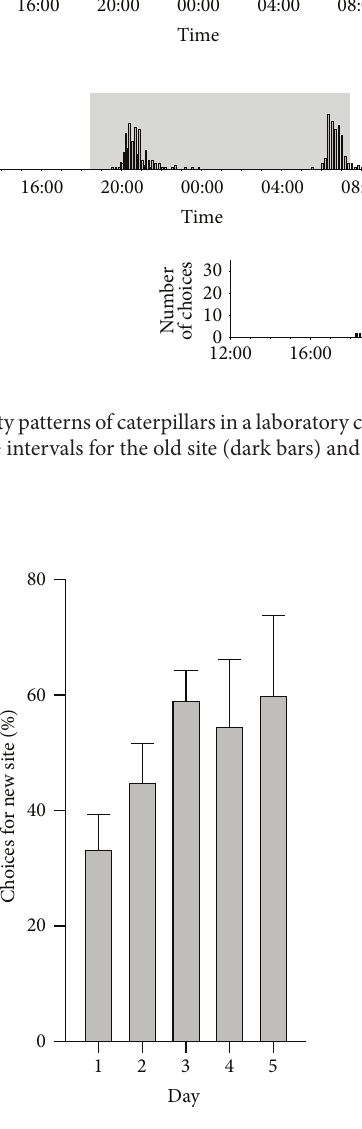
Figure 4: Mean percent ( ± SE) choices by fall webworm caterpillars for arms of Ys leading to new feeding sites at onset of evening for- aging